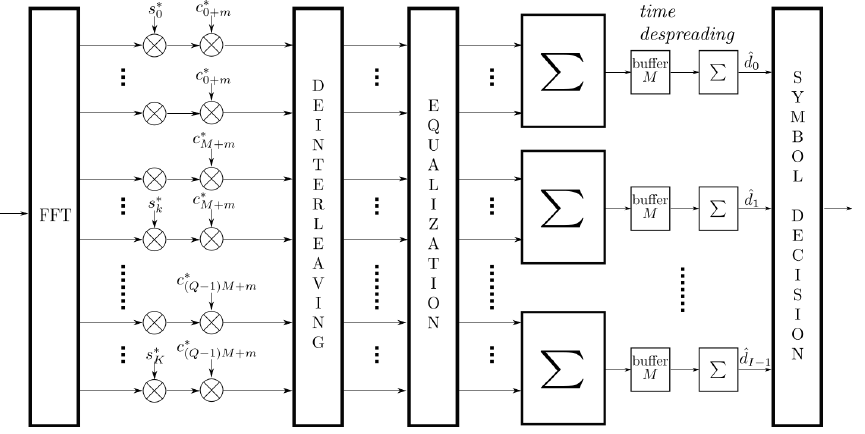
Figure 6. MC-SS 2D receiver